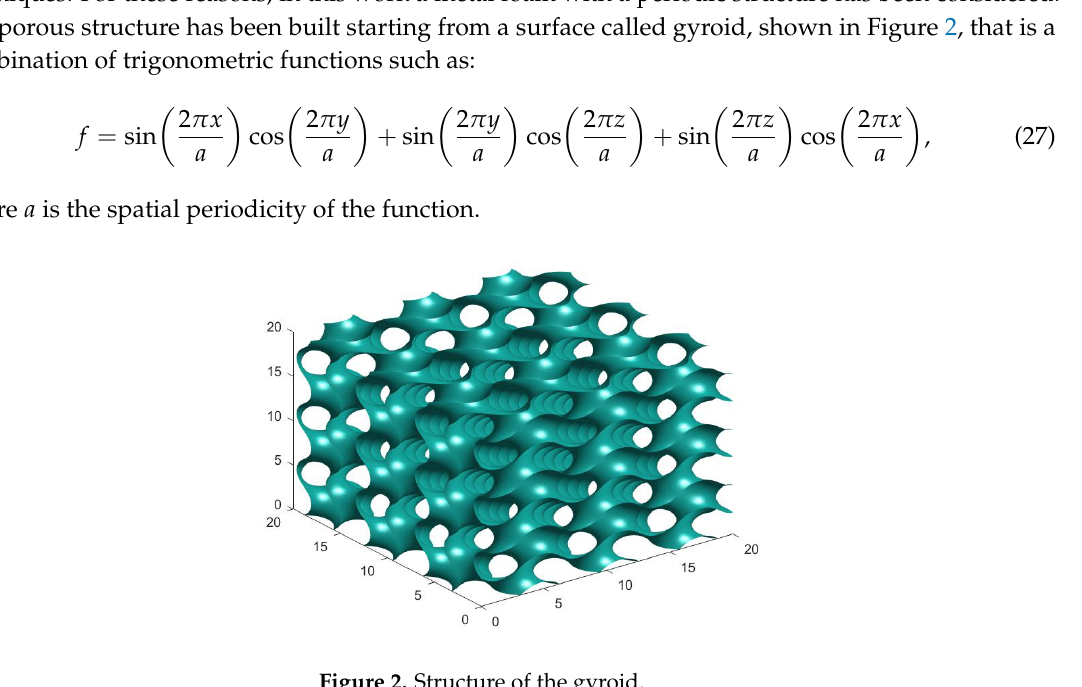
Figure 2. Structure of the